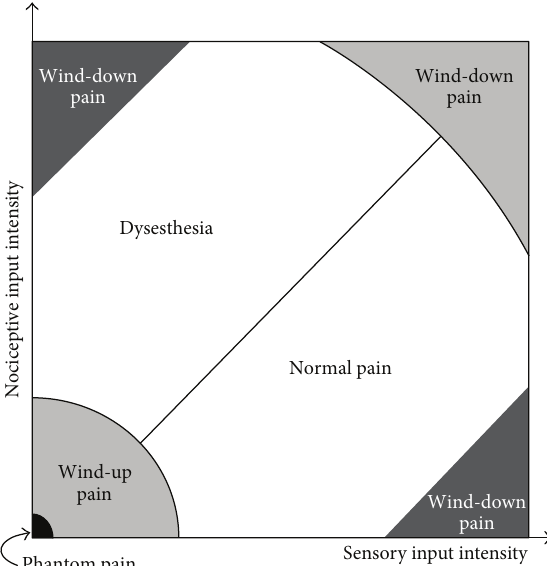
Figure 13: Different pain conditions for the different combinations of sensory and mechanoreceptor inputs according to the results of the gate circuit computer model. When the sensory input intensity (normalized firing rate) is higher than the nociceptive input inten- sity (below the diagonal), the circuit behaves in a “normal pain” mode. Above the diagonal, nociceptive input intensity is higher than the sensory input intensity. In this condition, the parameters of the gate circuit evolve so that pain is triggered in abnormal situations generating dysesthesia. When sensory and/or nociceptive inputs are very low, the gate circuit parameters evolve to produce wind-up pain. Phantom pain is included in this case as an extreme situation. Finally, when either nociceptive or mechanoreceptor stimulus is extremely high, wind-down pain is produced (see Figure 14).